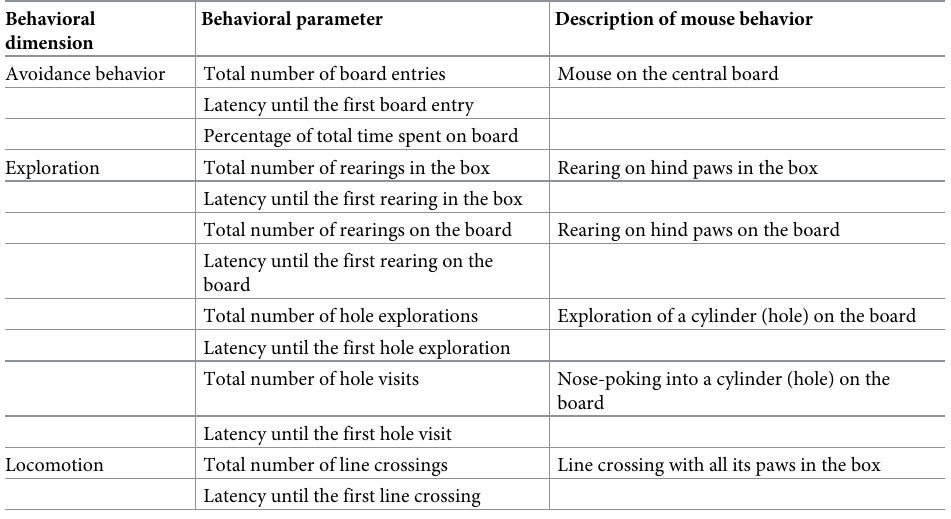
Table 1. Behavioral parameters measured in the modified Hole